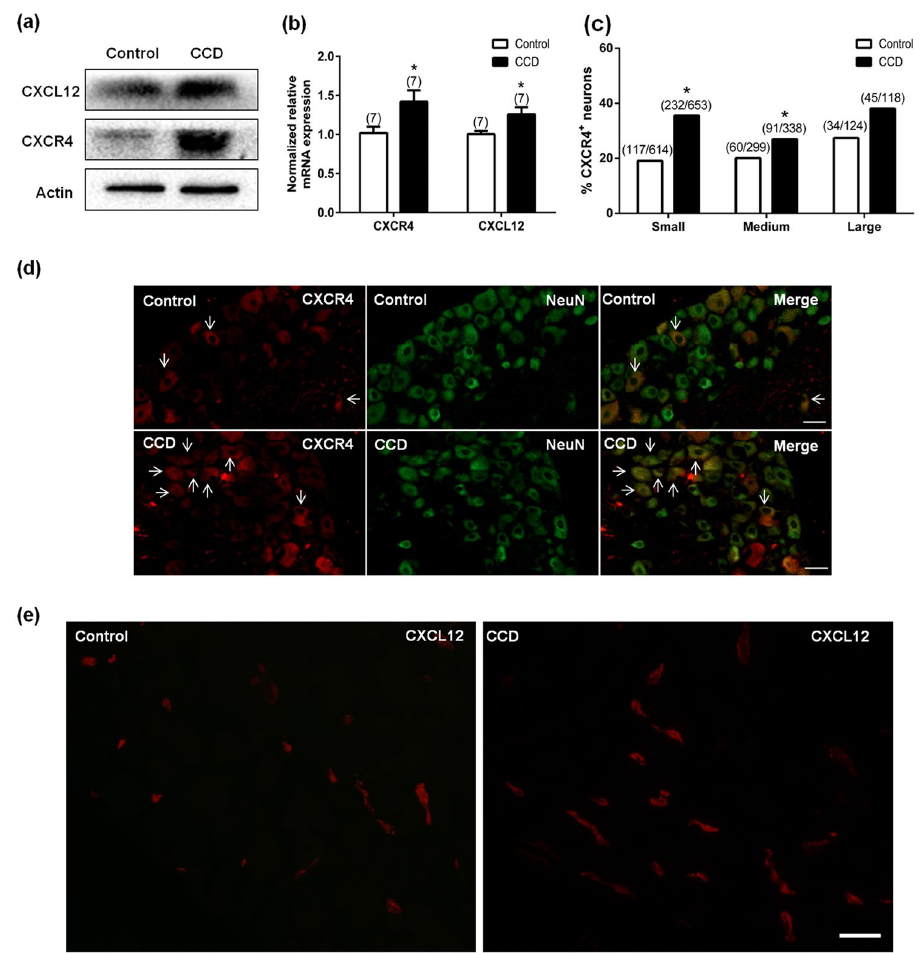
Figure 1. Expression of CXCL12/CXCR4 in mice DRG. ( a ) CXCL12 and CXCR4 protein expressions were increased on DRG after CCD (n = 4). ( b ) Both CXCL12 and CXCR4 mRNA were increased after CCD surgery 7 days (n = 7), * P < 0.05 vs. Control, unpaired t-test. ( c ) The percentages of CXCR4 positive small and medium neurons in the CCD mice were significantly greater than that from control animals, (n = 3, each group). * P < 0.05 vs. Control, Chi-square test. ( d ) Immunoreactivity for CXCR4 was increased after CCD surgery. The arrows indicated some positive neurons. Scale bar: 50 μ m. ( e ) Immunoreactivity for CXCL12 from CXCL12 DsRed knock-in mice was increased after CCD surgery. Scale bar: 50 μ